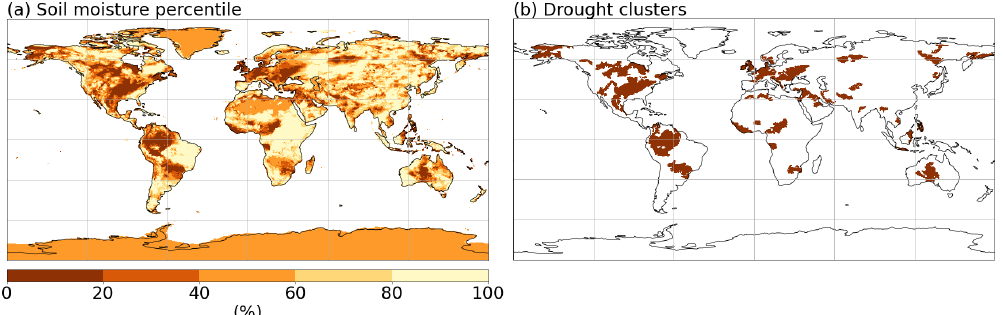
Figure 1. Demonstration of drought clustering. (a) Global map of soil moisture percentile for the root zone layer’s soil moisture in January 1964. (b) Drought clusters, spatially contiguous areas under drought (below the 20th percentile), are extracted from panel (a) . A 2D median filter is applied prior to drought clustering, which causes slight differences when compared with (a)